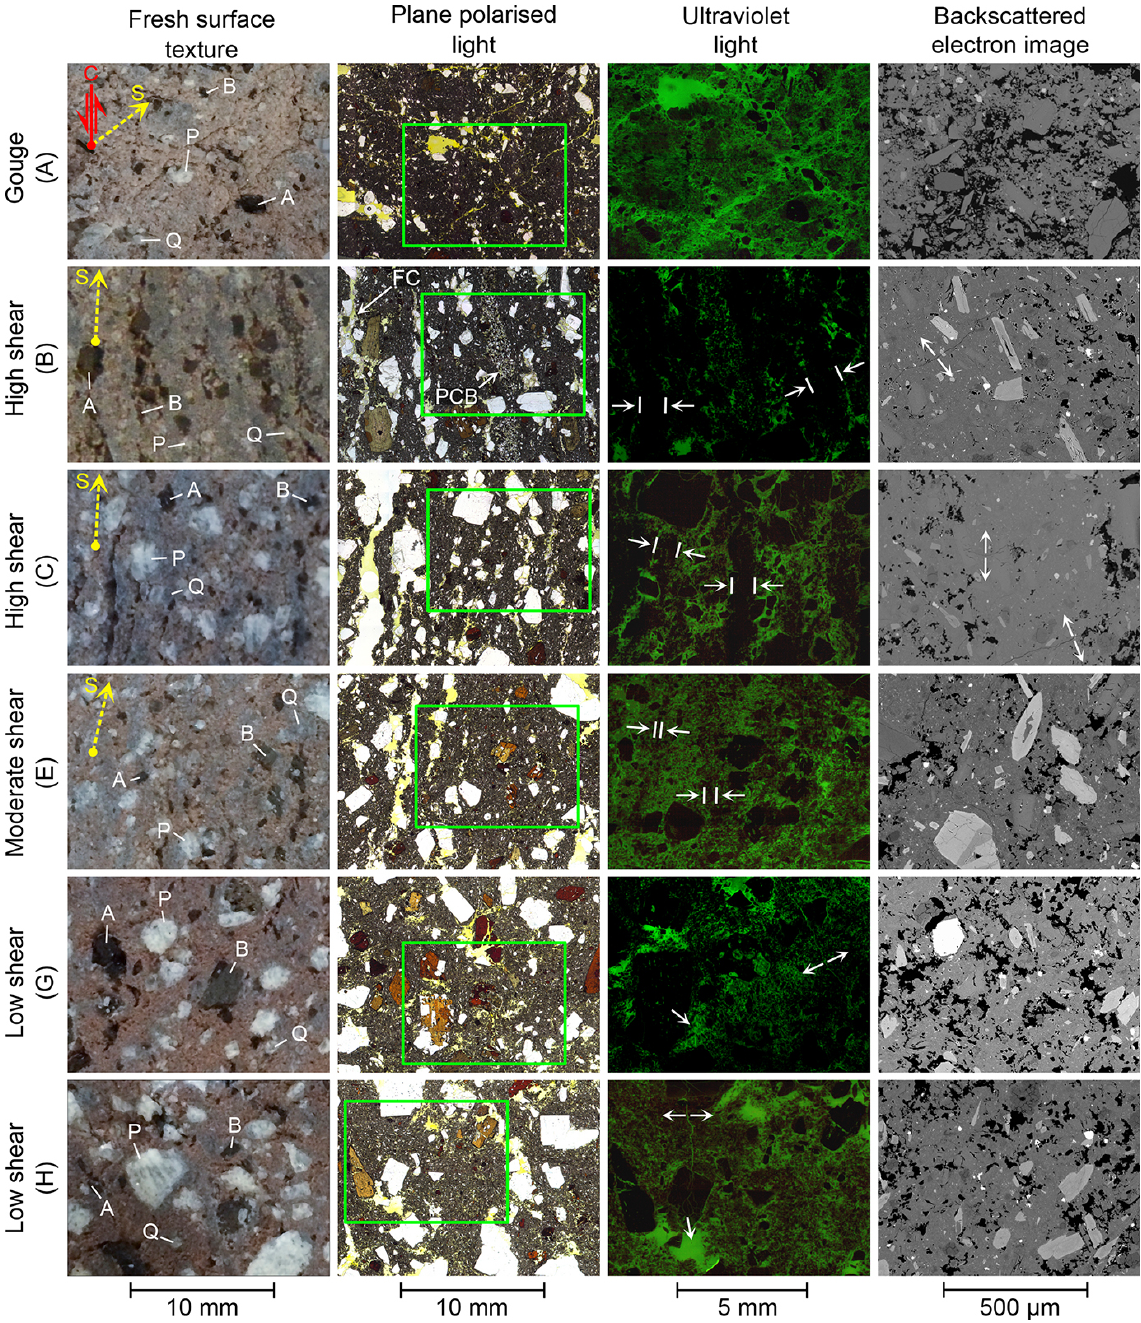
Figure 3. Composite figure of the microtextural characteristics across the marginal shear zone consisting of a photograph of fresh surface textures, plane-polarised light (PPL) photomicrographs, ultraviolet (UV) light photomicrographs, and backscattered electron (BSE) images of the groundmass. Images of the fresh surface were taken following cutting the sample perpendicular to shear. The C fabric (red line) and S fabrics (dashed yellow line) are labelled in gouge, high shear, and moderate shear zones. The C fabric runs consistently parallel to the shear direction, while the S fabric is slightly inclined to variable degrees across the MSZ. Phenocrysts observed include plagioclase (P), amphibole (A), biotite (B), and quartz (Q). Green boxes on PPL photomicrographs show the location of the UV light images, which highlight the pore structures across the MSZ. On UV light images, two white arrows pointing away from each other show the location of fractures within the groundmass (samples G and H), single arrows point to large pores adjacent to large phenocryst (samples G and H), and two arrows pointing towards each other show compaction bands (their spacing represents the width of each band; samples B and C). In the BSE images, a porous diktytaxitic texture is prevalent across the shear zone, although in the high shear zones (samples B and C) these textures are impeded by low-porosity compaction bands that show strong crystal alignment, fractured crystals (FCs), and pulverised crystal bands (PCBs). Solid Earth, 13, 875–900, 2022